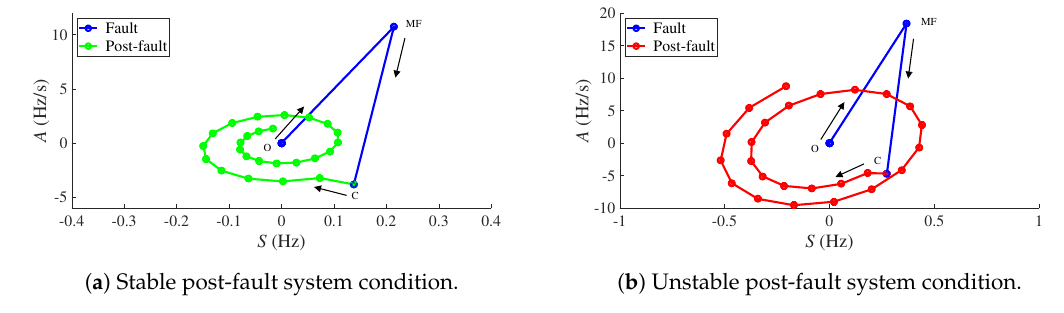
Figure 6. A k ( S k )